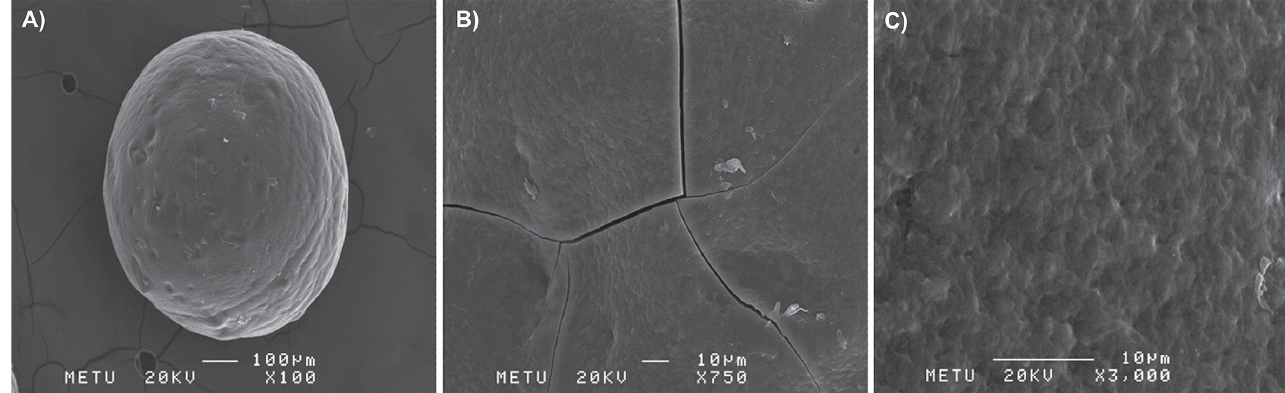
FIGURE 1 - Scanning electron micrographs of F2 coded chitosan microspheres before dissolution test: (A) general appearance and surface morphology (B, C).